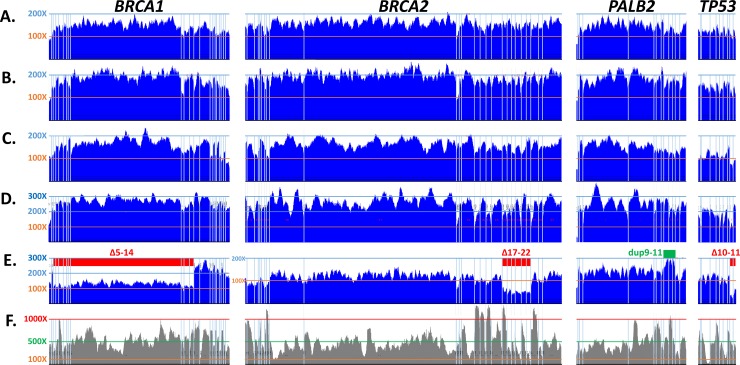
Coverage of selected genes from the CZECANCA (A-E) and TruSight Cancer sequencing (F) panels. The pictures show coverage (at y-axis) alongside the coding sequences of BRCA1 (NM_007294), BRCA2 (NM_000059), PALB2 (NM_024675), and TP53 (NM_000546), the vertical lines represent exon boundaries. Panels A–D show results obtained from a CZECANCA NGS analysis of various samples performed in four participating laboratories using the ultrasound (A, B) or enzymatic (C, D) DNA fragmentation protocol. Examples of the identified CNV aberrations in the depicted genes (deletions in BRCA1, BRCA2 and TP53 and duplication in PALB2) are shown in panel E. For comparison, panel F demonstrates the uneven coverage of the depicted genes by sequencing using the TruSight Cancer panel (Illumina).